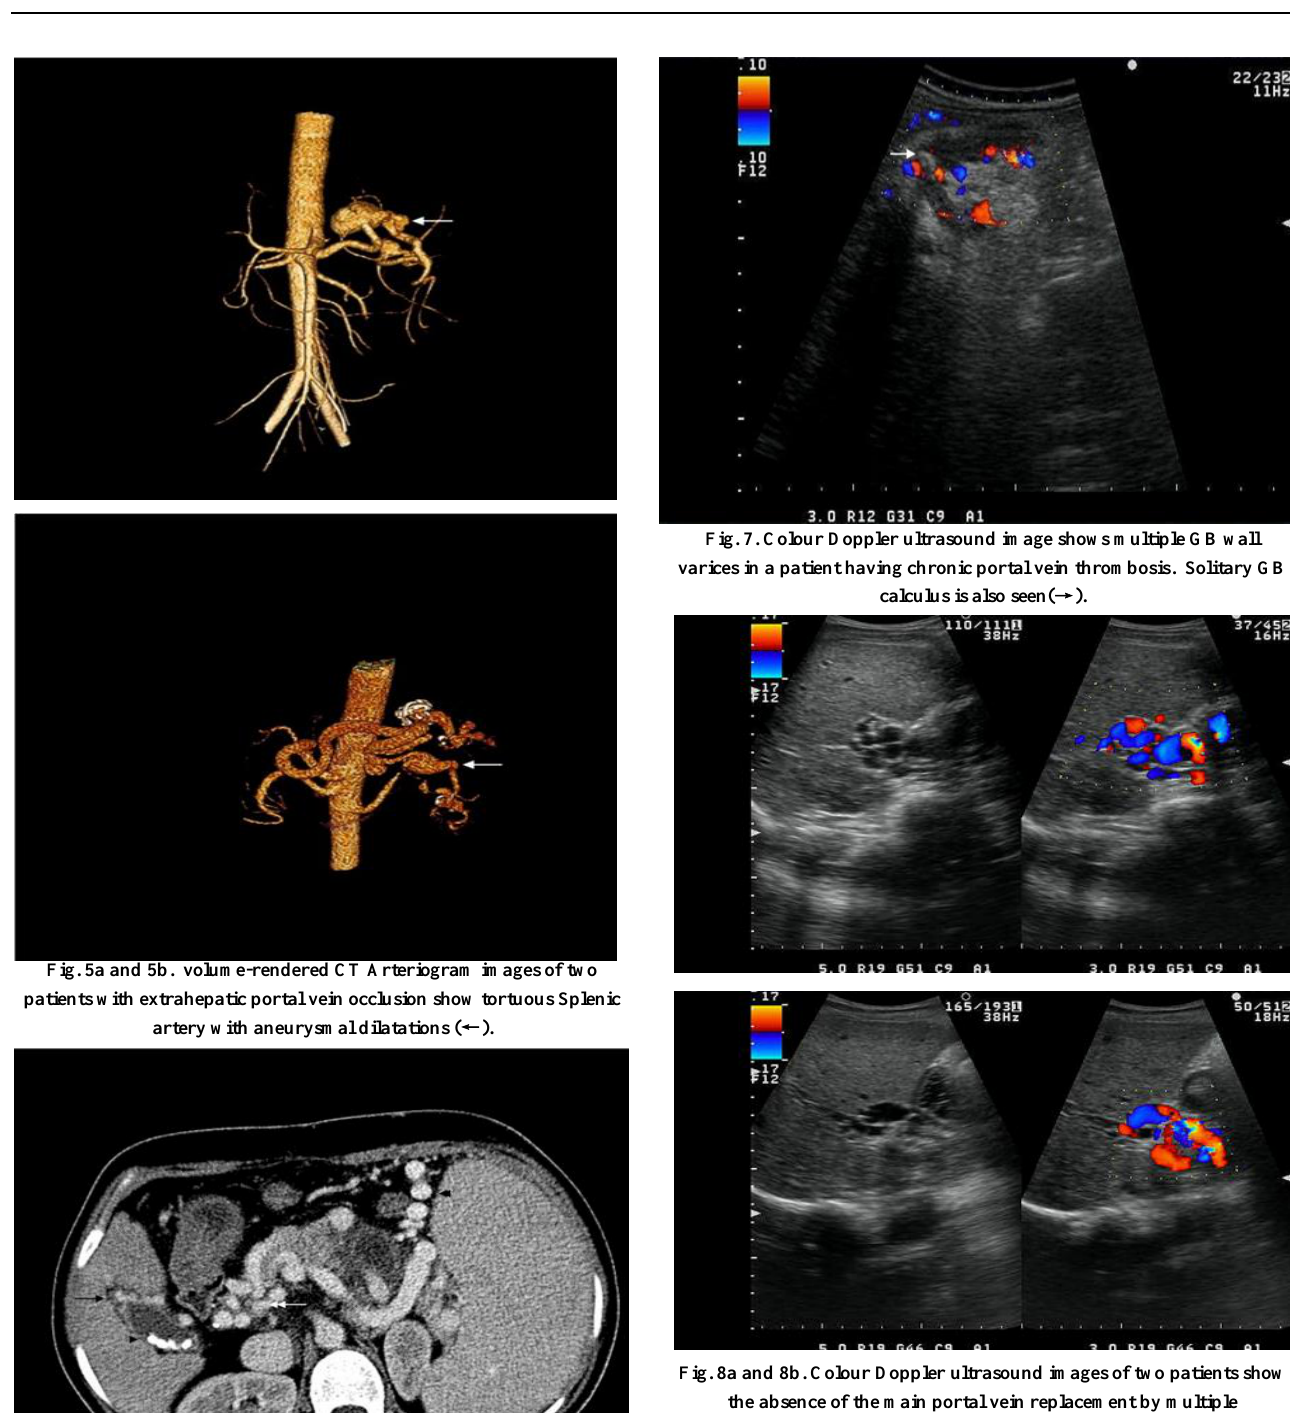
Fig. 6. Axial CT portal venogram image shows cavernomatous transformation of the portal vein(< ← ) with associated pericholecystic varices ( → ), peripancreatic collaterals, and mesenteric collaterals(<<). The note is also made of multiple GB calculi(>).